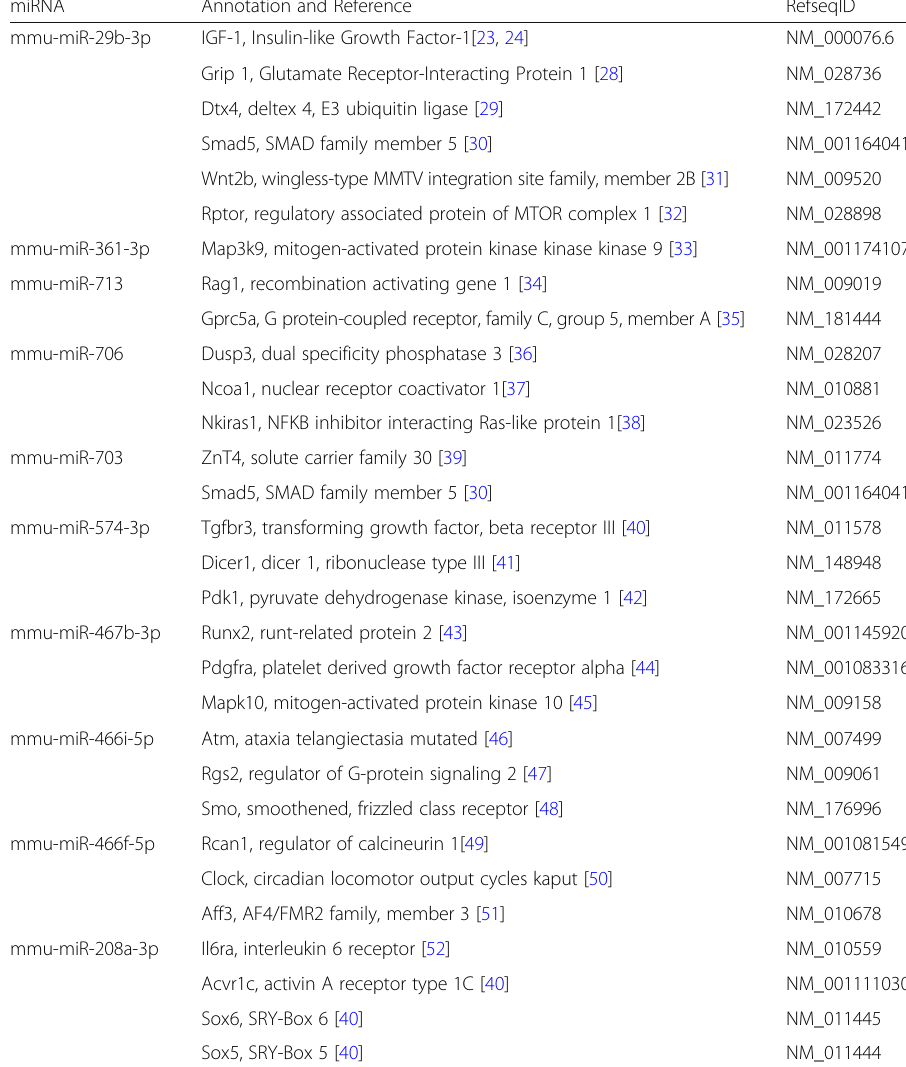
Table 1 Predicted target genes of the miRs miRNA Annotation and